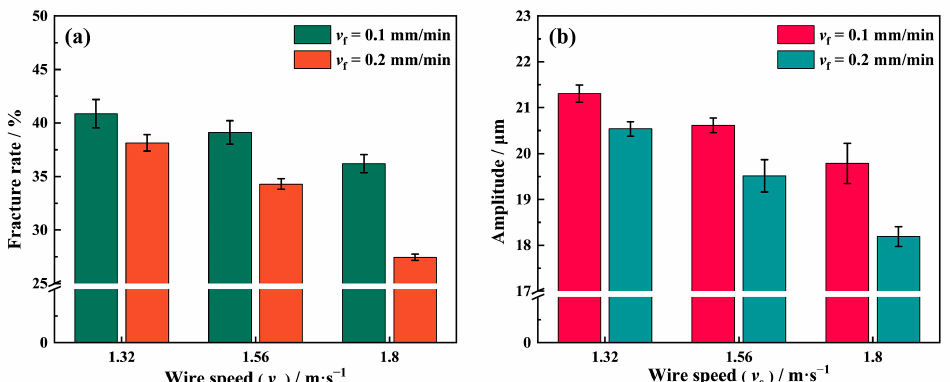
Figure 16. ( a ) Effect of the wire speed on the number of fracture chipping pits; ( b ) the amplitude of the wire vibration at P = 0.21 MPa, v f = 0.1 mm/min, and v f = 0.2 mm/min.